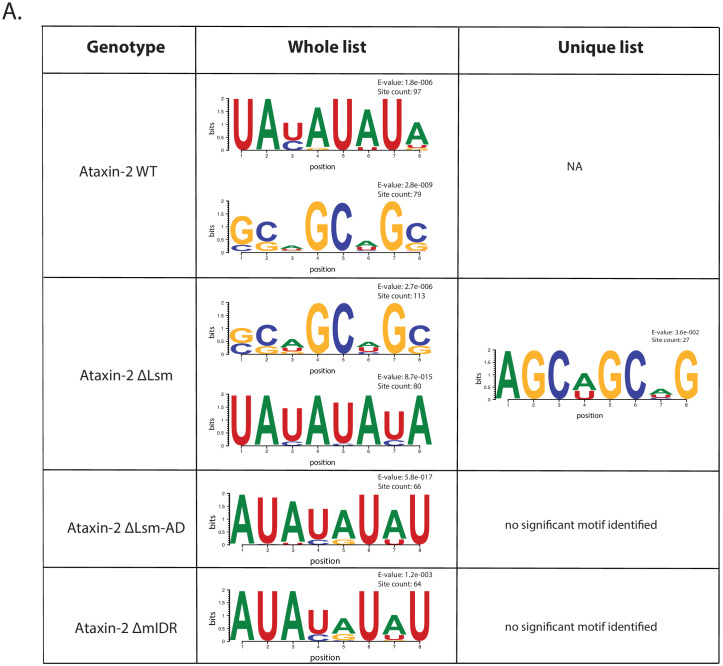
Atx2 Like-Sm (Lsm), Lsm-associated (LsmAD), or mIDR domains are not essential for AU-rich motif preference.MEME analysis showing Atx2 preferentially associates with AU-rich motif on target mRNA. Deletion of Lsm, LsmAD, or mIDR domains does not block the Atx2 AU-rich motif preference. Unique targets found in Lsm domain deletion have a GC-rich motif preference, which is also identified as the second most predominant motif that Atx2 WT bind.
Figure 4—figure supplement 1—source data 1.Mapping percentage for different Atx2 deletions.